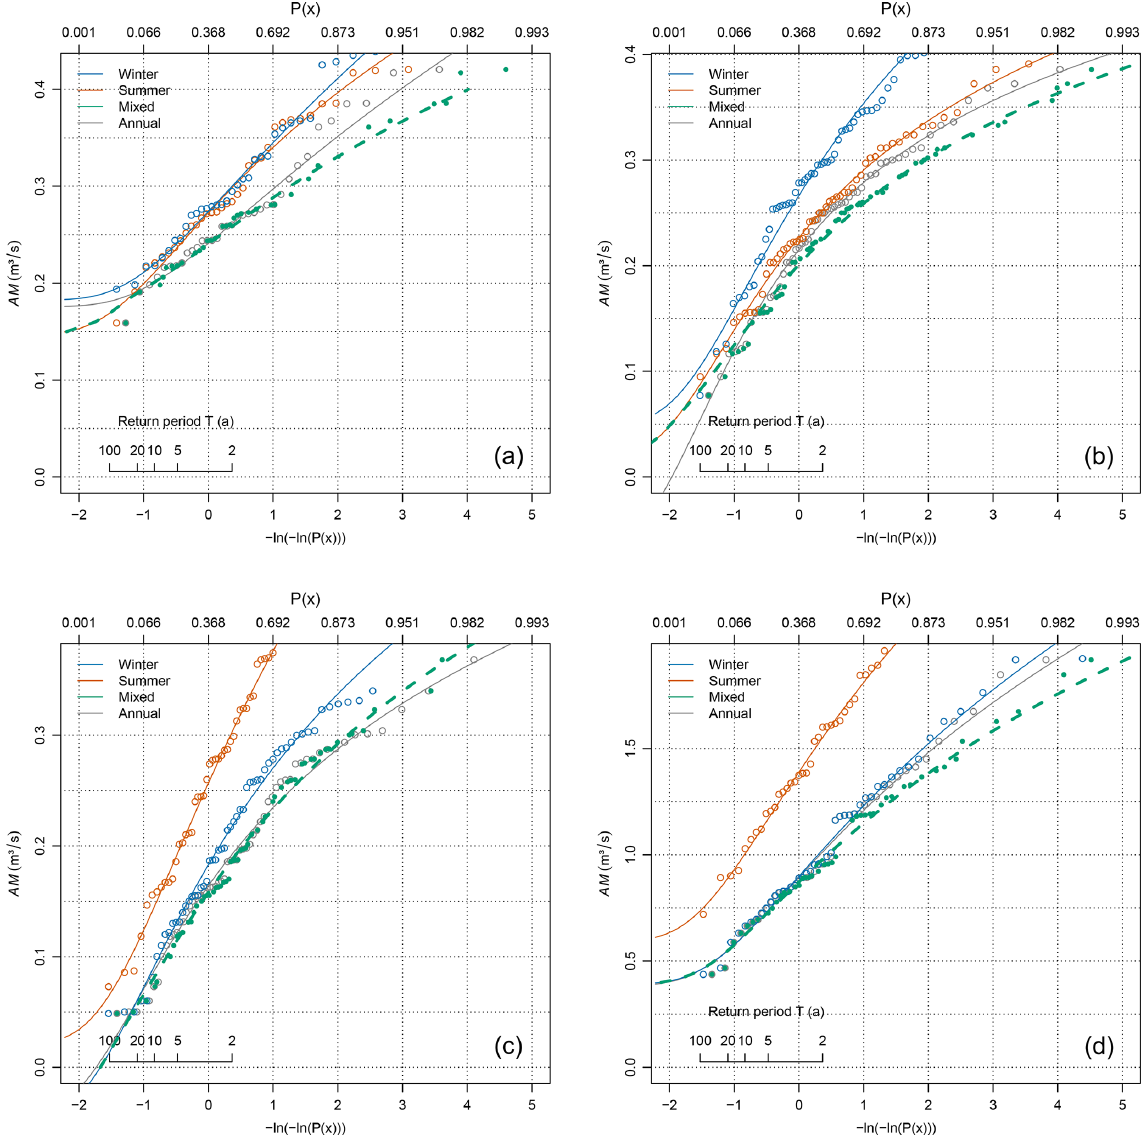
Figure 1. Probability plots of summer (red), winter (blue), annual (black), and mixed (green) distributions for archetypal cases. (a) Gauge Ebensee at river Langbathbach situated in the northern foothills of the Alps of Upper Austria; (b) gauge Weg at river Isen situated in low, hilly terrain in Bavaria, Germany; (c) gauge Schönenbach at river Subersach representing an alpine catchment of the Bregenzerwald in Vorarlberg, Austria; and (d) gauge St. Peter-Freienstein at river Vordernberger Bach representing an inner-alpine catchment in Styria,